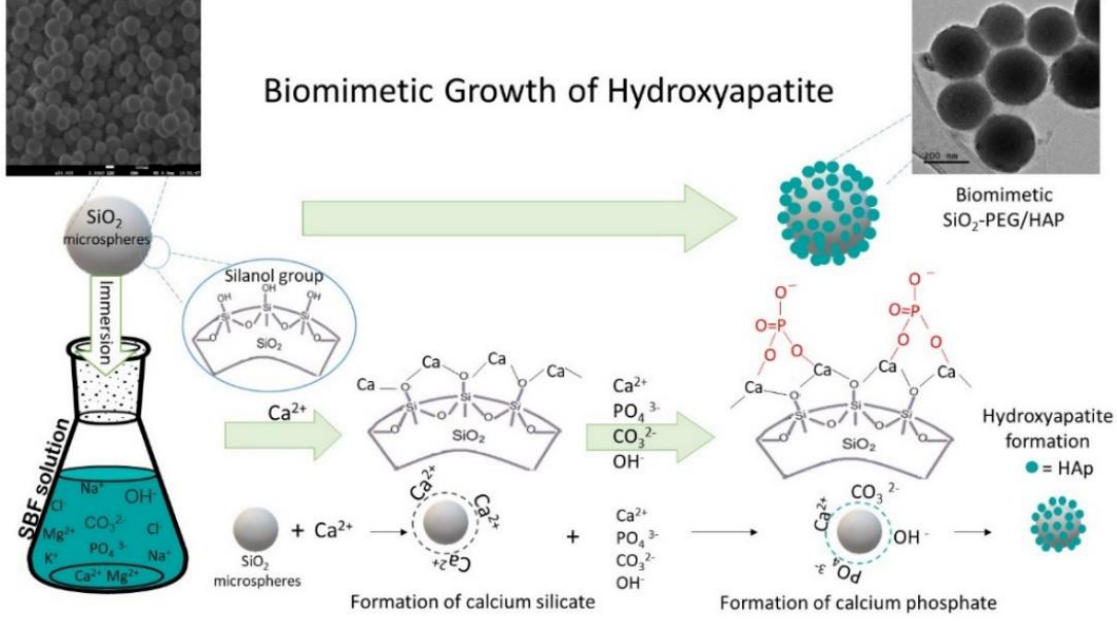
Figure 8. Illustration of the biomimetic growth of HAp on the surface of the silica microspheres.